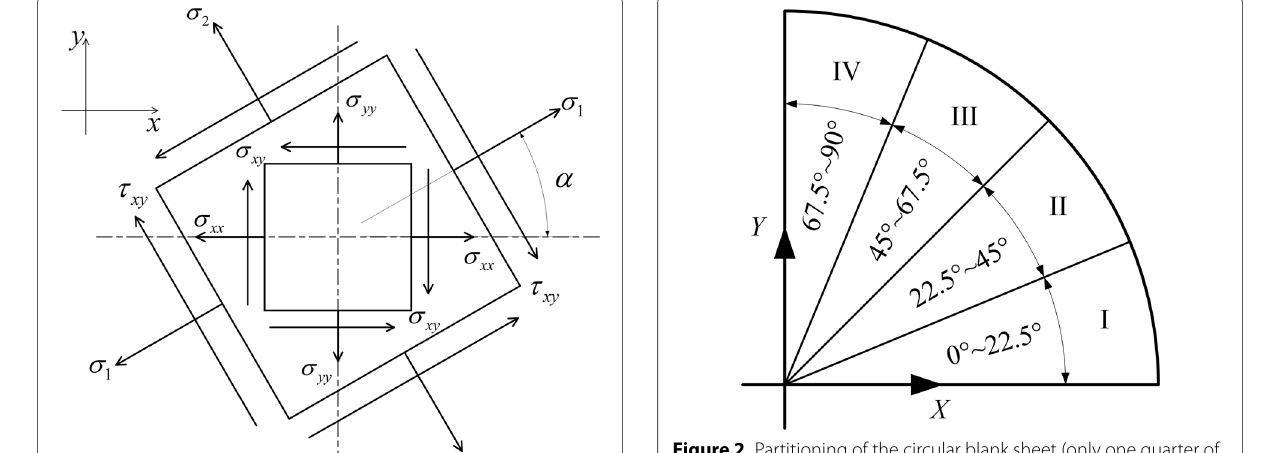
Figure 2 Partitioning of the circular blank sheet (only one quarter of the divided model is displayed, and the four parts are marked I, II, III, and